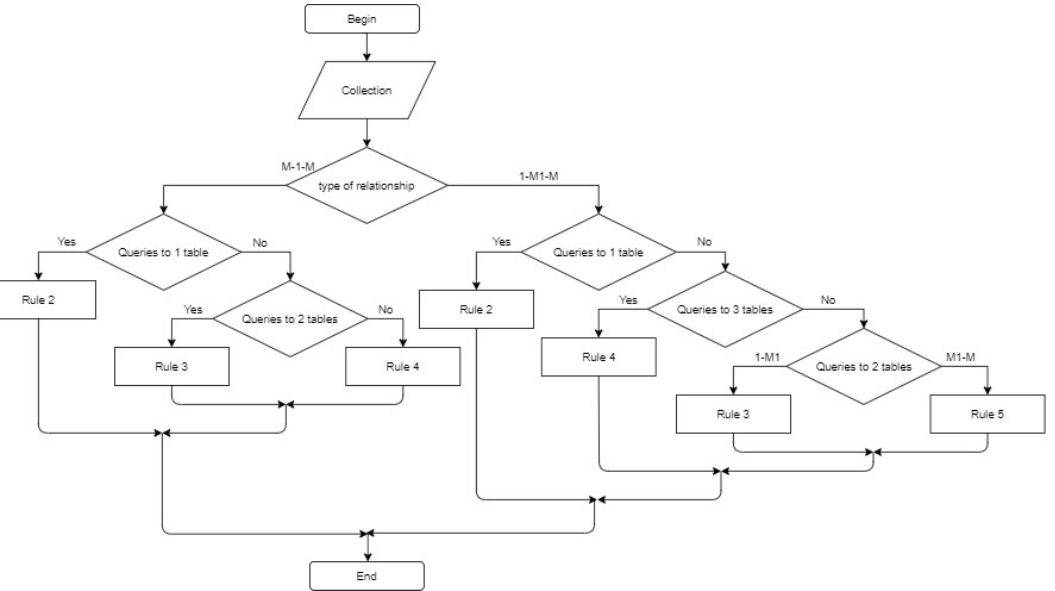
Table A1. Schematic representation of a document in a document database composed of attributes corresponding to the fields of different tables.